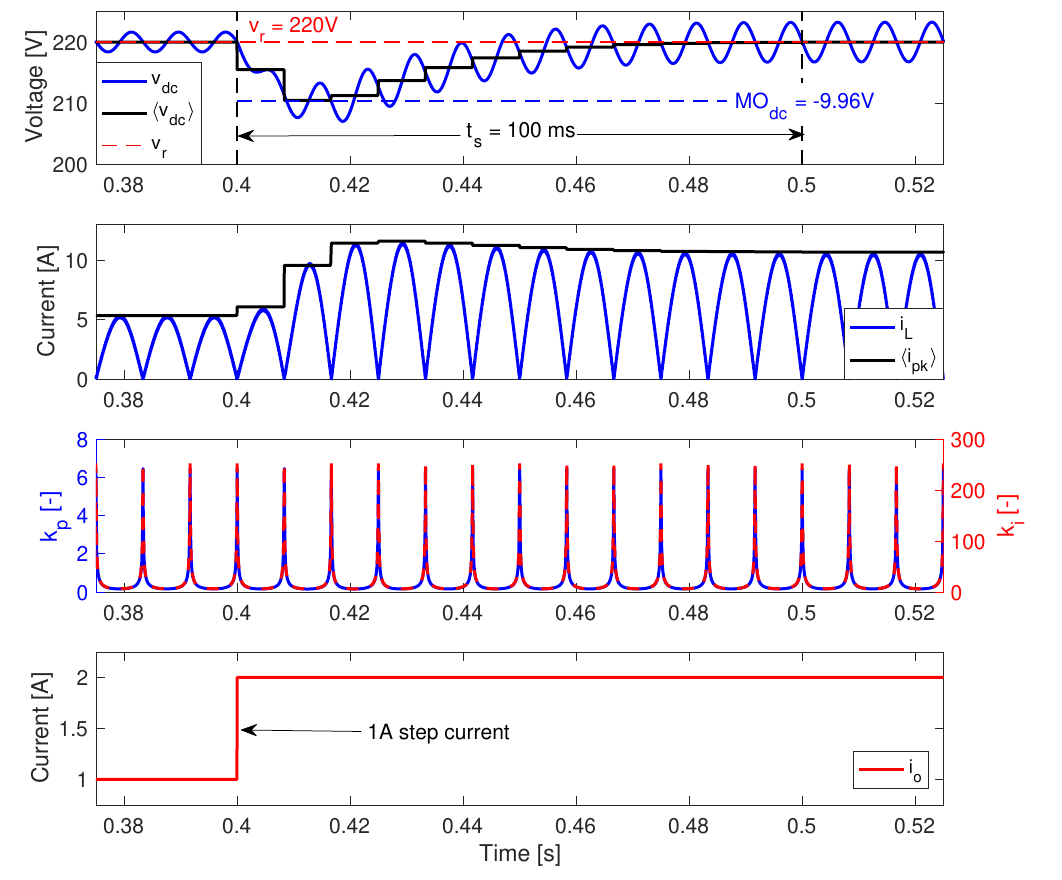
Figure 17. Validation of the capacitor and adaptive controller. In addition, Figure 18 provides a zoom of the low-frequency ripple at both steady-state conditions ( Io = 1 A and Io = 2 A). Since the design of ∆ v dc is performed for I o , max = 2 A, the voltage ripple at that condition perfectly march the expected value ∆ v dc = 3.2 V, while for Io = 1 A the voltage ripple is much smaller. Therefore, the simulations reported in Figures 17 and 18 confirm the correct operation of the adaptive voltage controller, and the correct design of C .